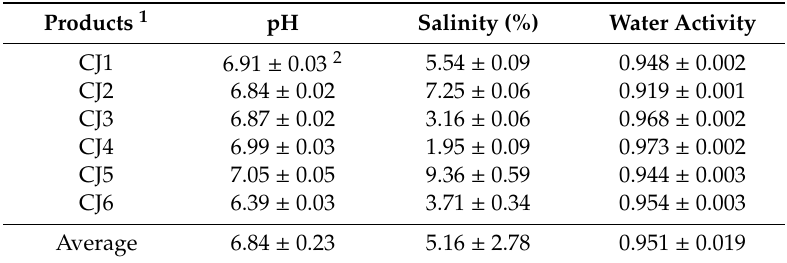
Table 1. Physicochemical properties of retail Cheonggukjang products. Products